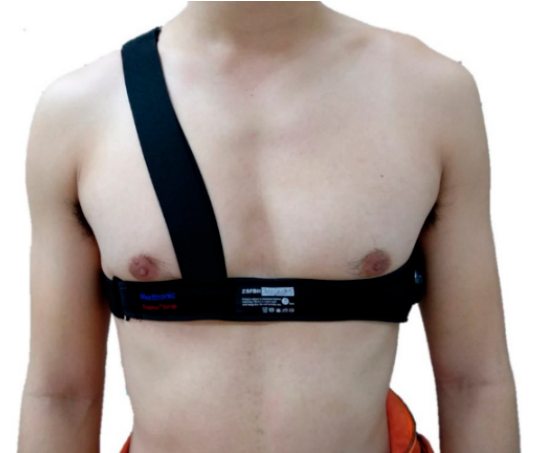
Figure 2. BioHarness 3.0 module attached to chest and shoulder straps.